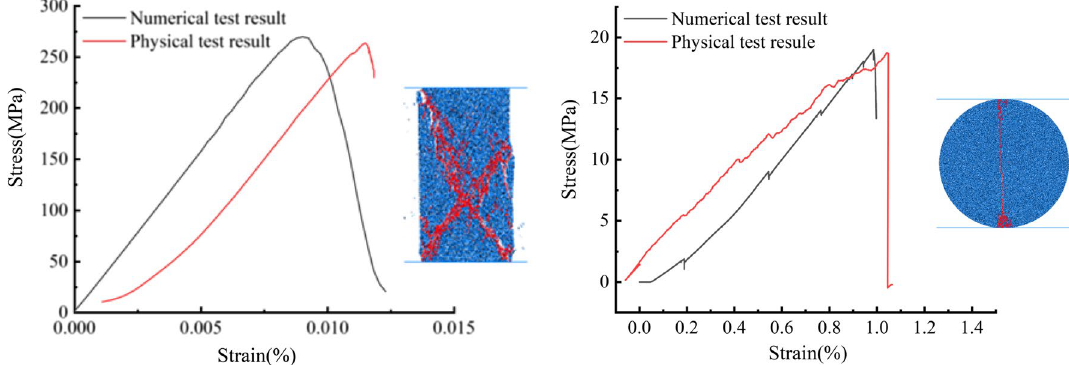
Fig. 4 Uniaxial compression test and split test results